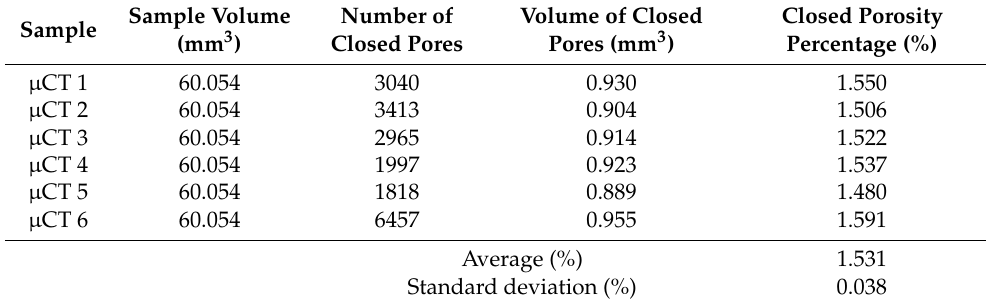
Table 3. Results of samples tested with MicroCT scan.